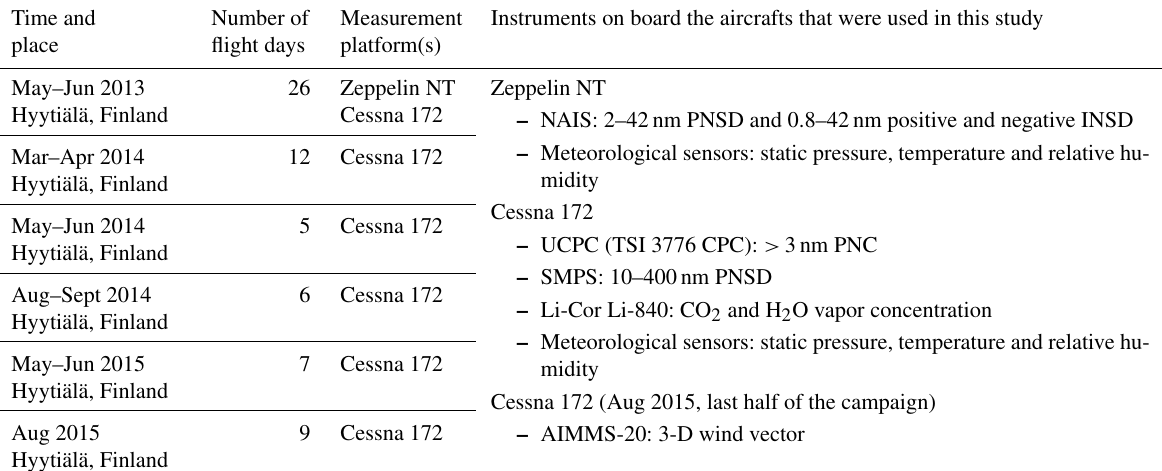
Table 1. Summary of airborne measurement campaigns from which data were utilized in this study. PNSD is particle number-size distribution, INSD is ion number-size distribution, and PNC is particle number concentration. Instruments on board the aircrafts that were used in this study